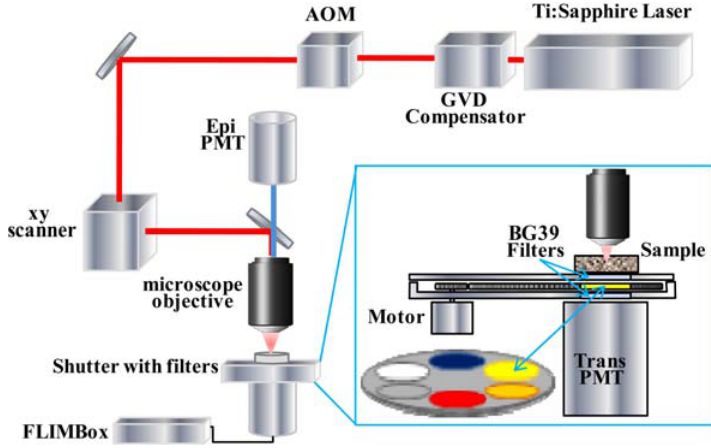
Fig. 1. Schematic diagram of the experimental